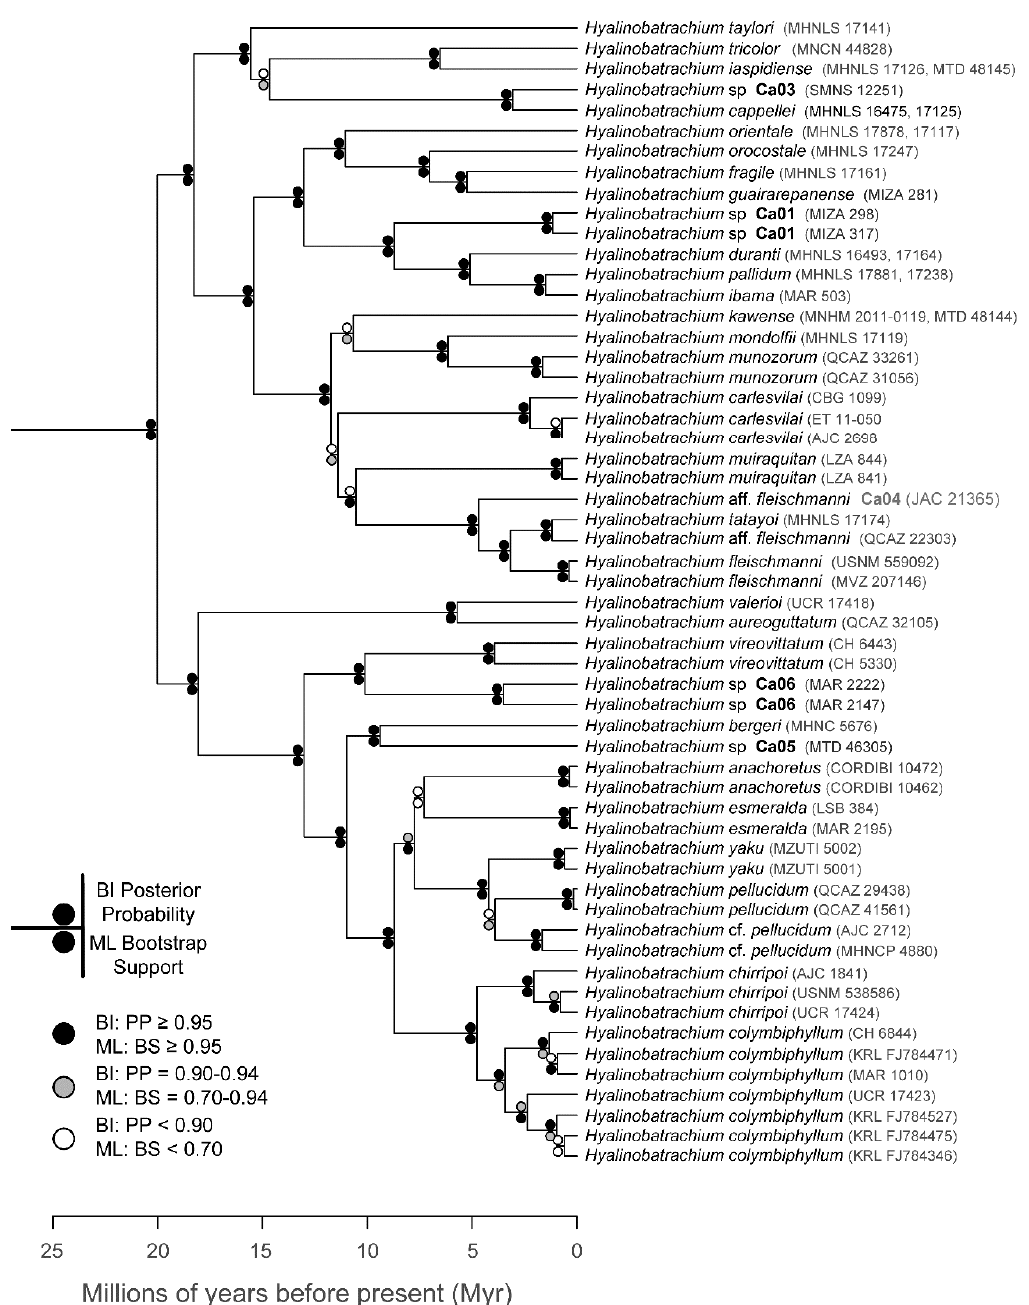
Figure 101. Evolutionary relationships among species in the genus Hyalinobatrachium , inferred using maximum likelihood and Bayesian criteria.